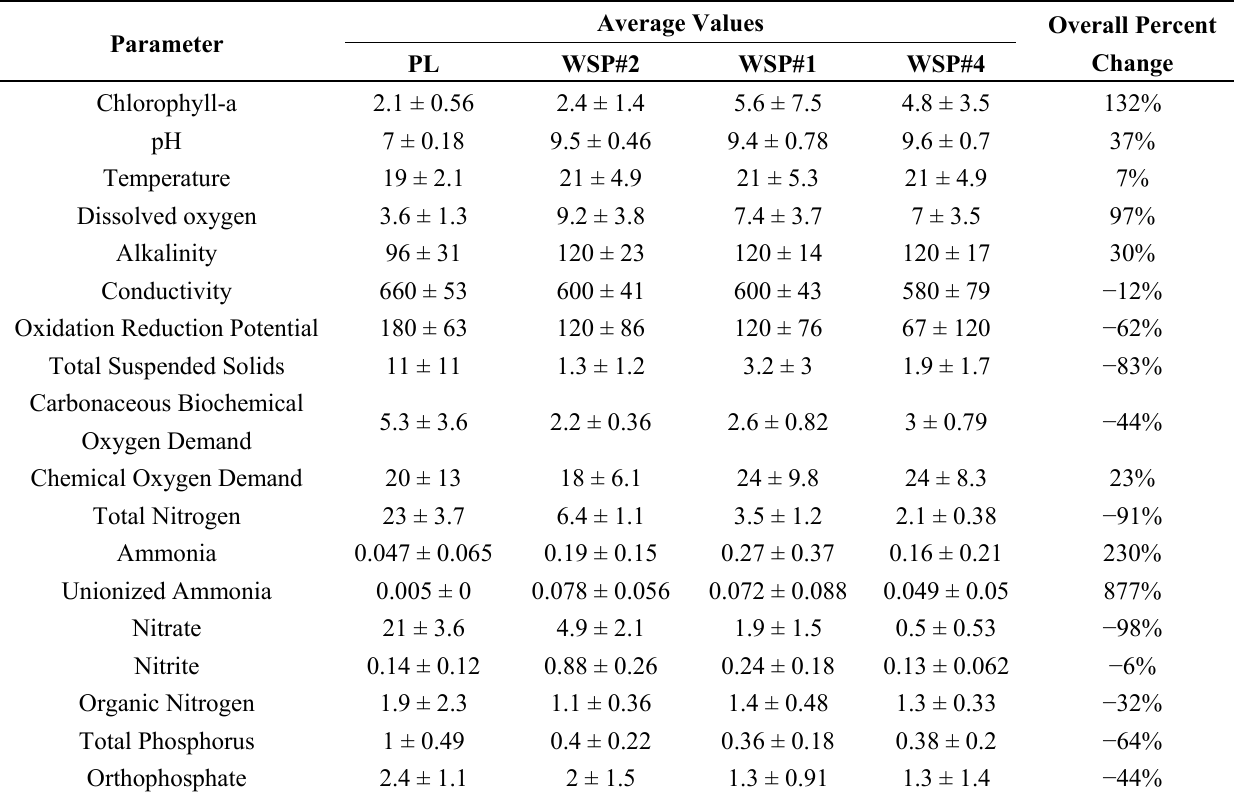
Table 4. Summary of system water chemistry parameters, with average values over the sampling period and percent change values across the WSP system over the July to September sampling